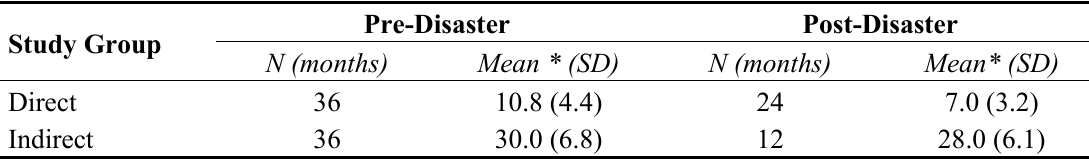
Table 1. Descriptive Statistics for Untransformed Time Series Data by study group, SC Medicaid ACSC discharges ± 2002–2006.